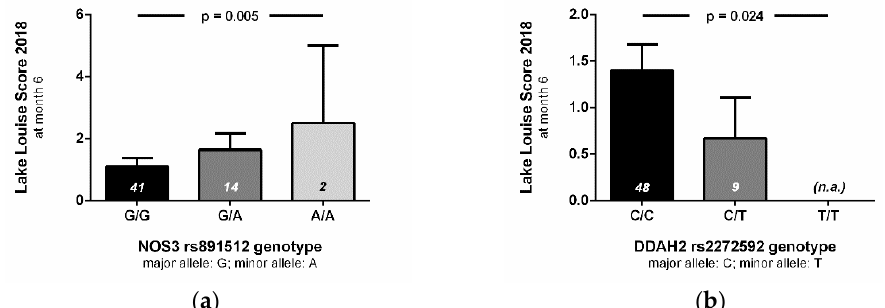
Figure 4. Relationship of genotypes with high-altitude acclimatization. Lake Louise Score (2018) values assessed at month 6 of chronic intermittent hypobaric hypoxia are given in relation to genotypes of the NOS3 rs891512 ( a ) and the DDAH2 rs2272592 single nucleotide polymorphism ( b ). Data are given as mean ± S.E.M. of n = 57 individuals. p values denote the results of multivariable-adjusted regression analysis.